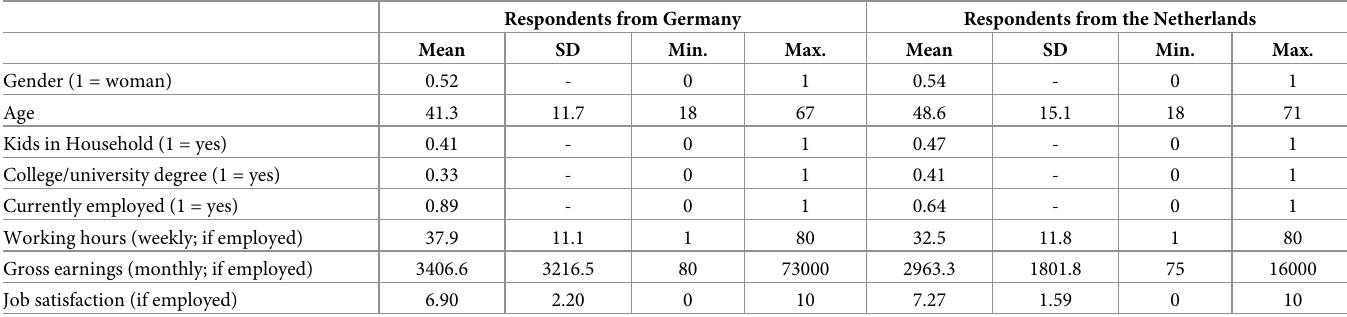
Table 1. Description of the German and Dutch